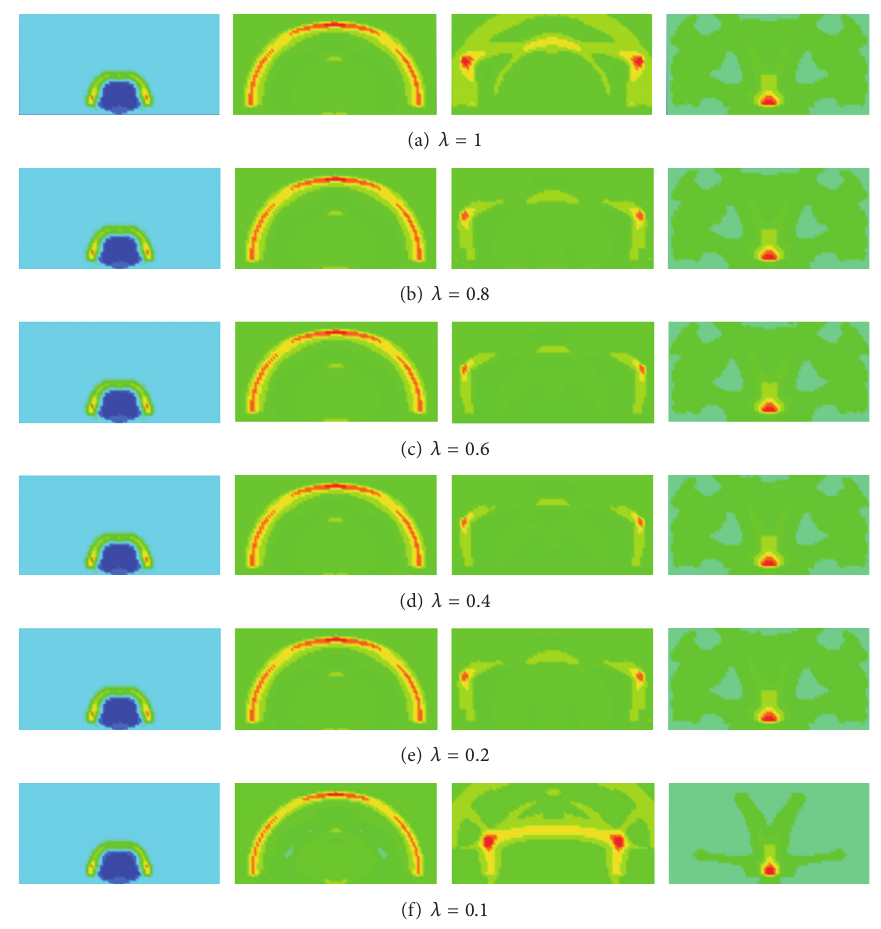
Figure 3: Shock wave overpressure nephogram of each scale